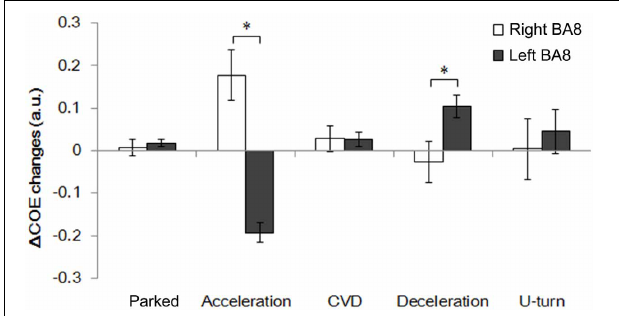
FIGURE 8 | Comparison of (cid:2) COE in the left and right BA8. Changes in (cid:2) COE in the left BA8 (Ch 24, white) and the right BA8 (Ch 26, black). The graph shows the results of the daytime experiments; the results of the nighttime experiments were similar. ( ∗ p < 0 .